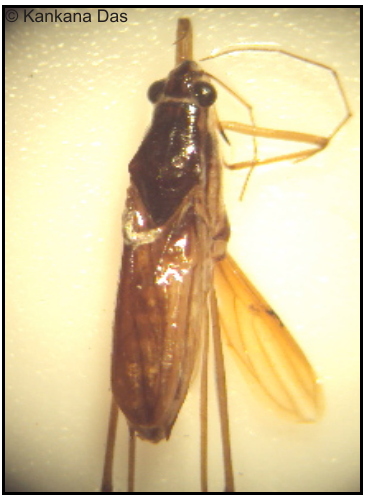
Image 7. Limnogonus nitidus (Mayr)